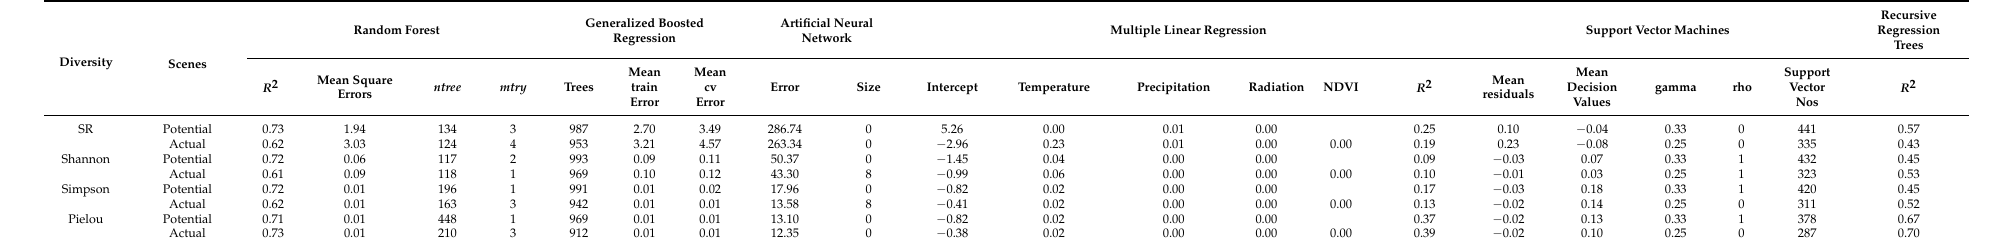
Table 1. The parameters for random forest, generalized boosted regression, artificial neural network, multiple linear regression, support vector machines and recursive regression trees of potential and actual species richness, Shannon, Simpson and Pielou,